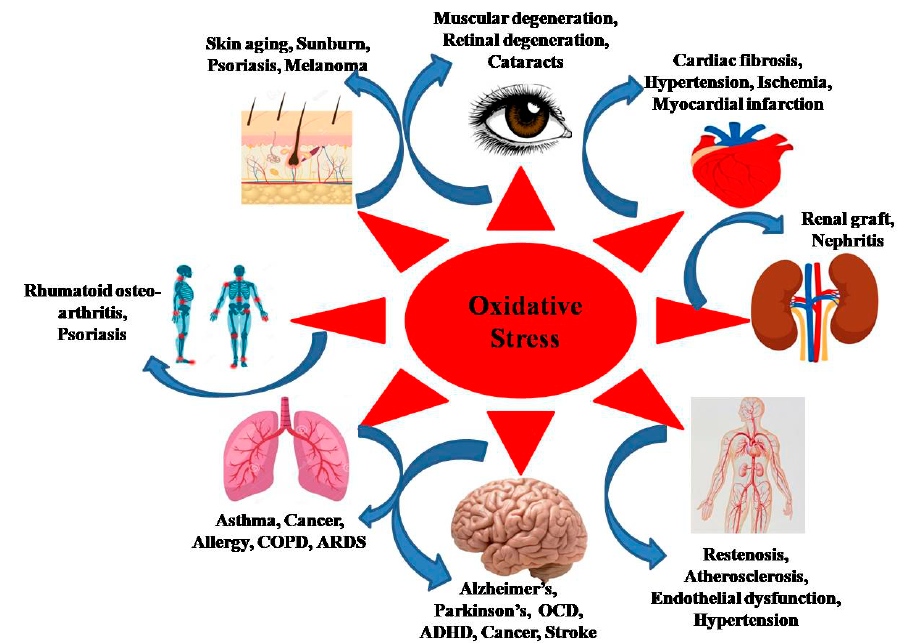
Figure 1. side effects of oxidative stress on human body. COPD—Chronic obstructive pulmonary disease; ARDS—Acute respiratory distress syndrome; OCD—Obsessive-compulsive disorder; ADHD—Attention-deficit/hyperactivity disorder.